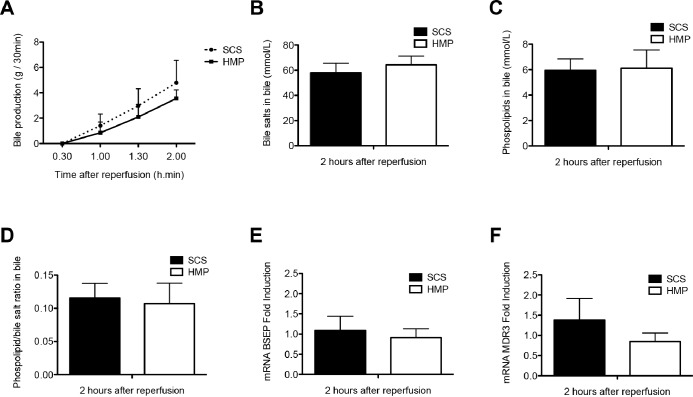
Parameters of hepatocellular secretory function of DCD livers that were preserved by either 4 h of oxygenated HMP or SCS and subsequently reperfused for 2 h by normothermic 
ex vivo sanguineous perfusion.
Panel A: Evolution of bile production in the HMP and SCS group. Panel B and C: Biliary concentration of bile salts and phospholipids, respectively. Panel D: Bile salt toxicity, as represented by the ratio of biliary bile salt and phospholipid concentrations. There were no statistically significant differences between the groups. Panel E–F: Relative mRNA expression of the main hepatocellular bile transporters BSEP (bile salt export pump; Abcb11) and MDR3 (multidrug resistance protein 3, Abcb4) after 2 h of ex vivo sanguineous reperfusion of DCD livers that were preserved by either 4 h of oxygenated HMP or SCS. There were no significant differences between the two groups.